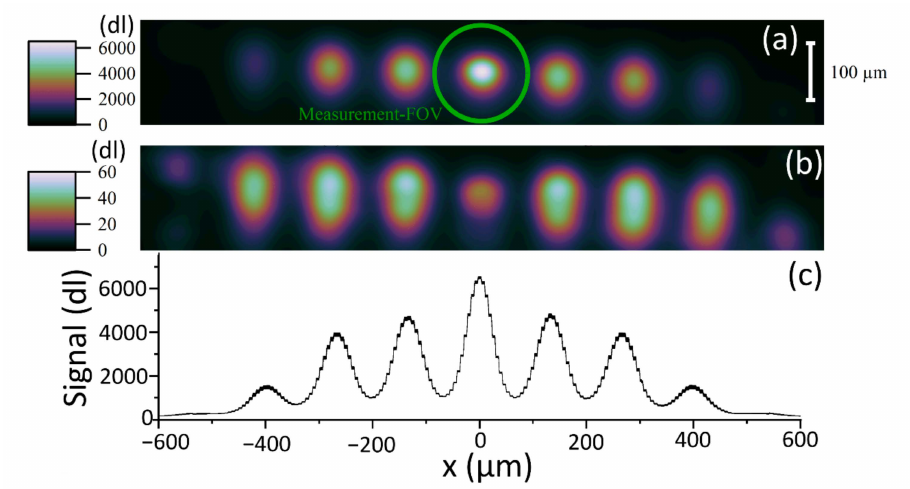
Figure 9. ( a ) Mean of 2156 183 × 29 pixel Regions of Interest (ROIs) around the central HAZ cropped from the captured images as per Figure 4. ( b ) Standard error in the mean of the 2156 ROI images making up the mean. ( c ) Line profile of ( a ) showing the 95% confidence interval as the vertical line thickness. The size of the Measurement FOV is included to illustrate that a correction for the spatial transfer function of the thermographic instrument must be made. The scale for ( a , b ) is shown in the top right and is in